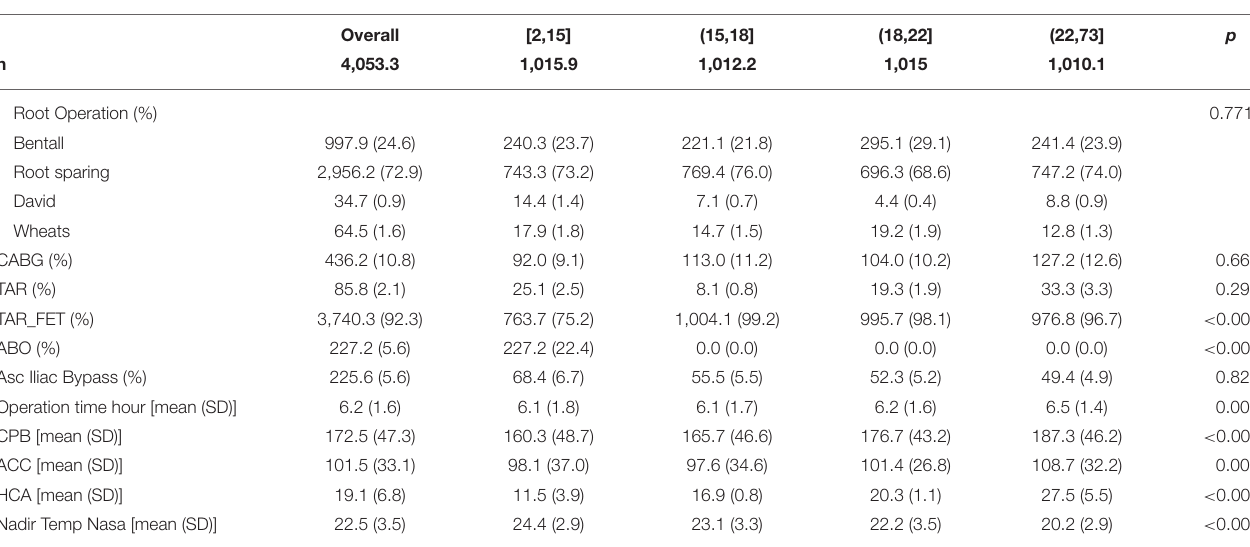
TABLE 2 | Operative data after propensity score